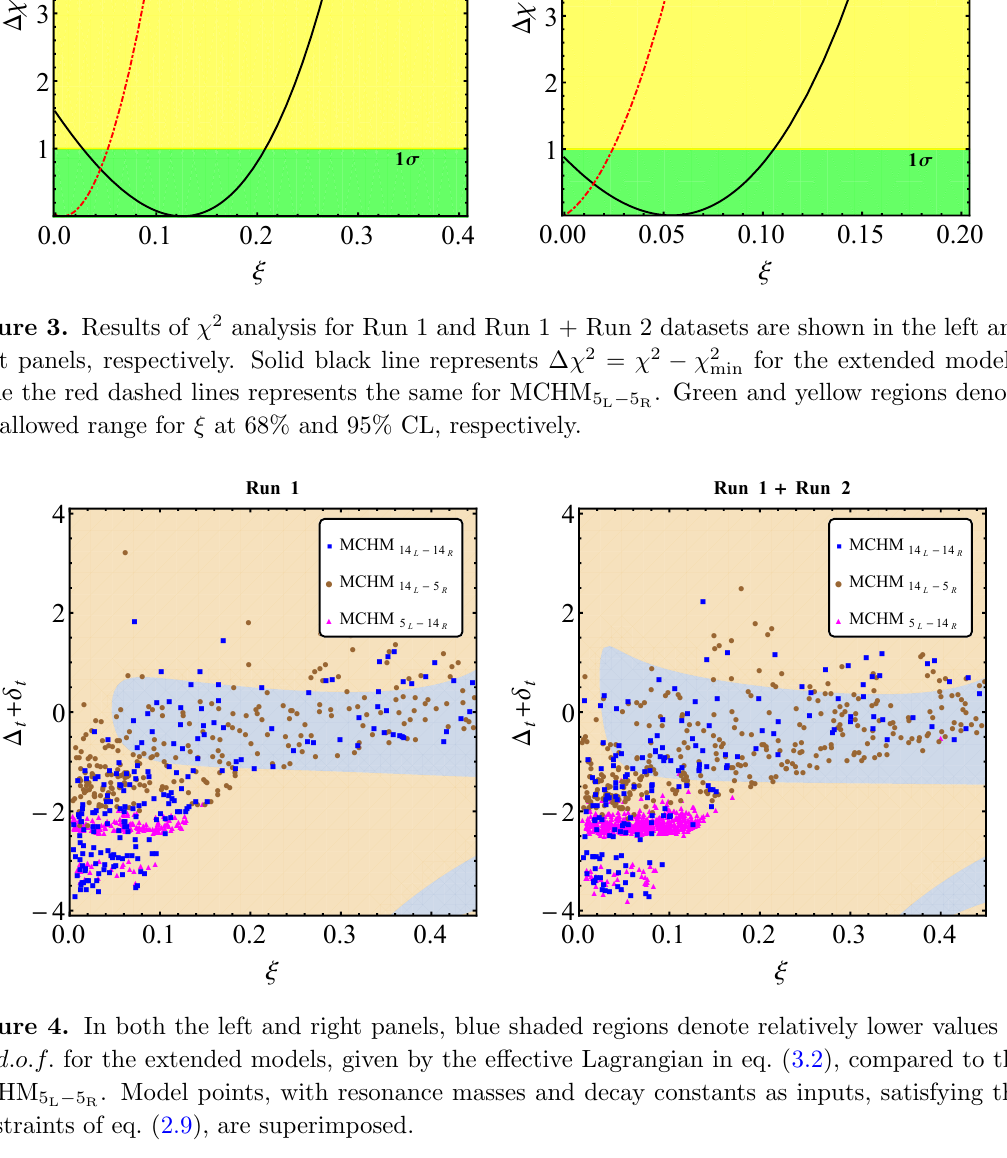
Figure 4. In both the left and right panels, blue shaded regions denote relatively lower values of (cid:31) 2 =d:o:f: for the extended models, given by the e(cid:11)ective Lagrangian in eq. (3.2), compared to the MCHM 5 . Model points, with resonance masses and decay constants as inputs, satisfying the L (cid:0) 5 R constraints of eq. (2.9), are